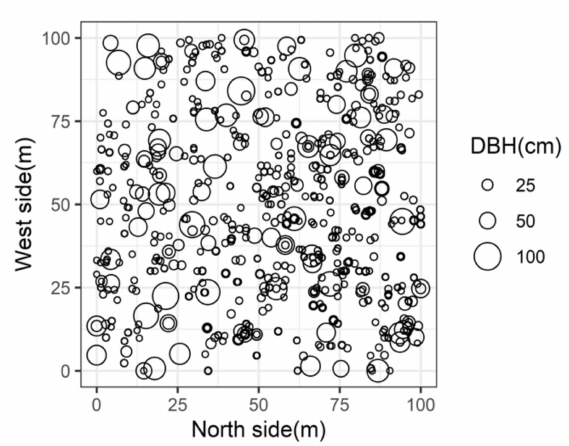
Figure 2. The spatial distribution of living trees. The circle size indicates diameter of breast height (DBH) of living trees their DBH are ≥ 5